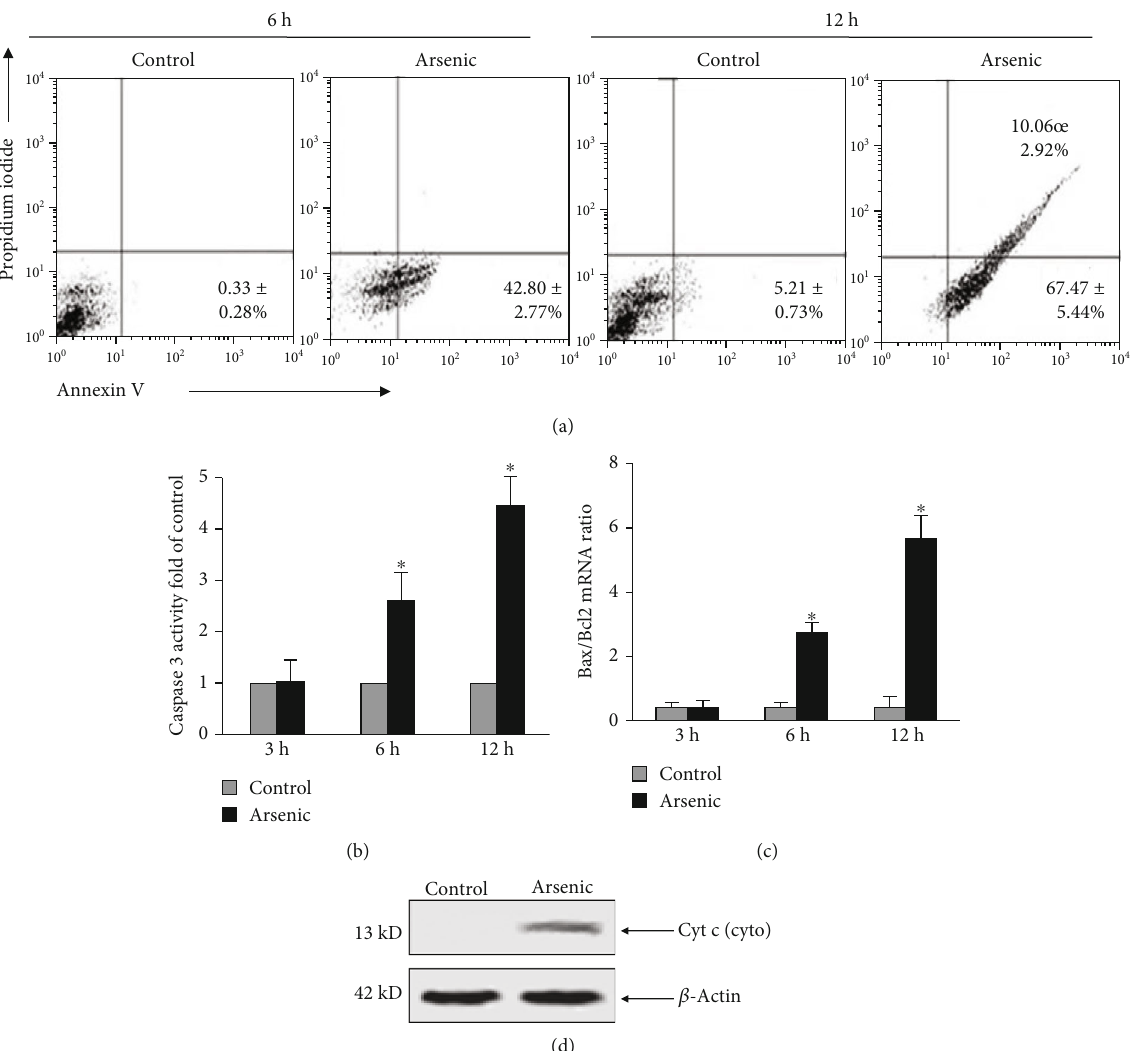
Figure 6: Mode of cell death due to arsenic exposure at a dose of 10 μ M was assessed by Annexin V and propidium iodide staining. (a) Flow cytometric quanti fi cation of the percentage of dead cells at 6h and 12 h of arsenic exposure using Annexin V and PI staining. The data are representative photomicrographs of 6 independent experiments. (b) Caspase 3 activity was quanti fi ed by ELISA at di ff erent hours of arsenic exposure. The results are representative of 6 independent experiments. ∗ p < 0 : 001 vs. control. (c) mRNA expression of the proapoptotic protein Bax and antiapoptotic protein Bcl2 was quanti fi ed using real-time PCR and plotted graphically. ∗ p < 0 : 001 vs. control. (d) Representative Western blot of cytochrome c from the cytosol of control and arsenic-treated